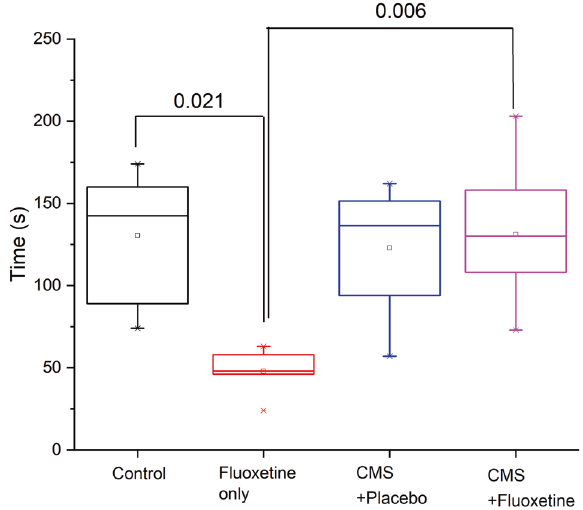
Fig. 2 Immobile time under the forced swimming test (FST) in the control, fl uoxetine only, CMS + placebo and CMS + fl uoxetine groups.